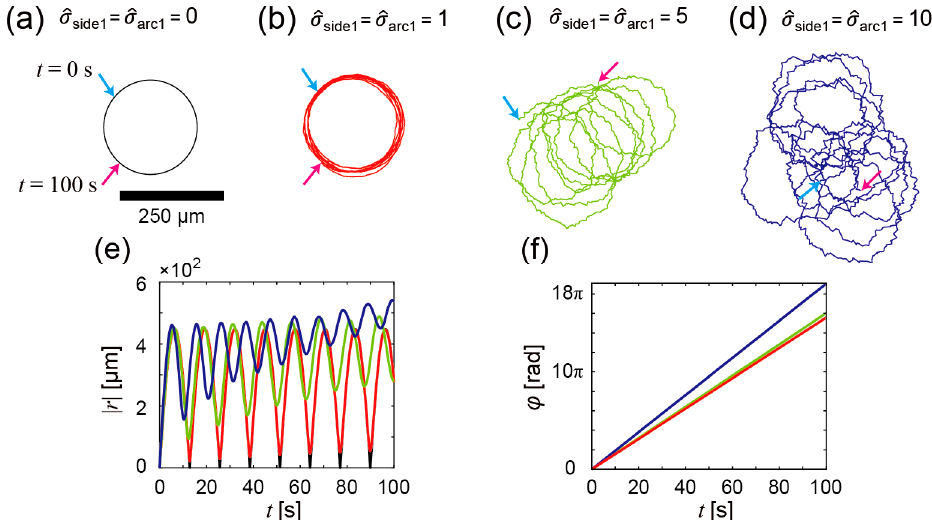
Figure 4. Numerical analyses of bubble propulsion of the propeller-shaped micromotors with a single catalytic site. ( a – d ) Calculated trajectories of the micromotor in each condition of ˆ σ side1 and ˆ σ arc1 . ˆ σ side1 = ˆ σ arc1 = 0 ( a ); ˆ σ side1 = ˆ σ arc1 = 1 ( b ); ˆ σ side1 = ˆ σ arc1 = 5 ( c ); ˆ σ side1 = ˆ σ arc1 = 10 ( d ); Cyan arrow: t = 0 s; magenta arrow: t = 100 s; ( e ) The time variation of | r ( t )|. Black line: For trajectory of ( a ); red line: For trajectory of ( b ); green line: For trajectory of ( c ); blue line: For trajectory of ( d ); ( f ) The time variation of ϕ ( t ) . The notation of each line is the same as in ( e ).